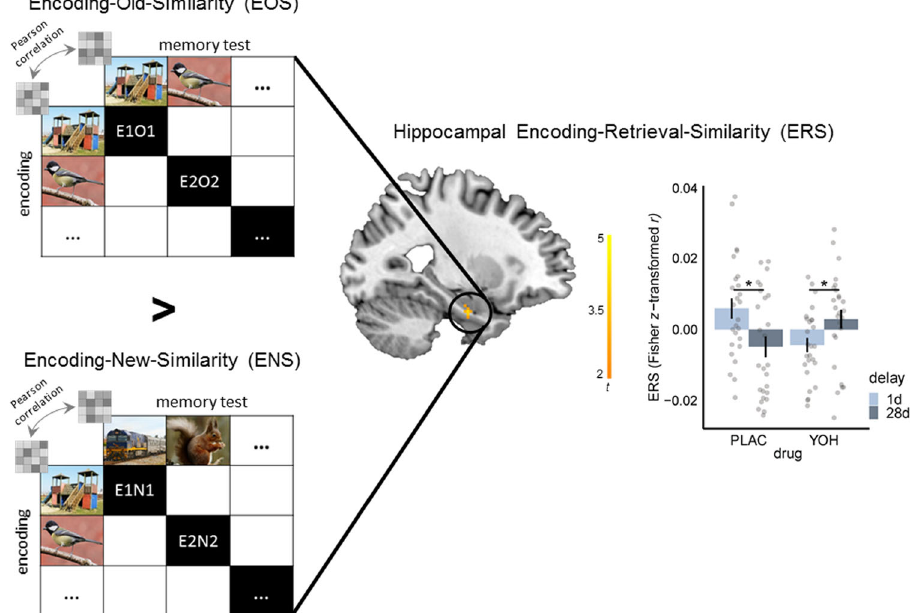
Fig. 4 Multivariate encoding-retrieval-similarity (ERS) analysis. Participants of the placebo (PLAC) group showed a signi fi cant decrease in hippocampal pattern reinstatement, as re fl ected in ERS, from 28d relative to 1d ( p = 0.010, two-tailed Welch ’ s t -test), while there was even a signi fi cant increase in hippocampal ERS from the 1d to the 28d test in the yohimbine (YOH) group ( p = 0.031, two-tailed Welch ’ s t -test; drug × delay: SVC peak-level: x = − 26, y = − 10, z = − 26, mixed ANOVA; n = 104 participants). Bonferroni correction was applied for the number of regions of interest in each analysis. All images are licensed under Creative Commons License; image of the playground courtesy of Tomasz Sienicki (https://commons.wikimedia.org/wiki/ File:Playground_29_ubt.JPG; image unchanged); image of the bird courtesy of Francis C. Franklin (https://commons.wikimedia.org/wiki/File:Great_tit_ side-on.jpg; image unchanged); image of the train courtesy of DBZ2313 (https://commons.wikimedia.org/wiki/File:Locomotive_NR27_hauling_Indian_ Paci fi c_train_(cropped).jpg; image unchanged); and image of the squirrel courtesy of Peter Timing (https://commons.wikimedia.org/wiki/File:Squirrel_ posing.jpg; image unchanged). Visualizations of the ERS results include the t -map for drug × delay superimposed on a sagittal section of a T1-weighted template image and the Fisher z- transformed r -values for the signi fi cant cluster in the contrast EOS > ENS. Bars represent mean ± SEM. Source data are provided as Source data fi le. * p <